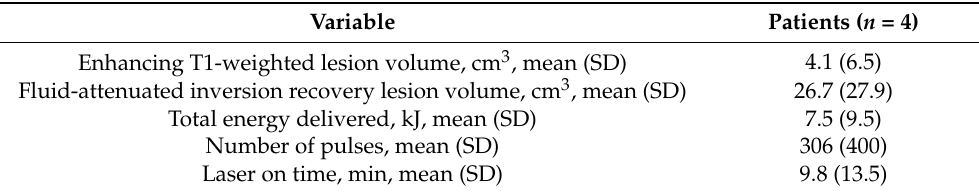
Table 3. Lesion volumes and treatment parameters of 9 patients with low-grade glioma (LGG) and radiation necrosis (RN) treated with laser interstitial thermal therapy (LITT).